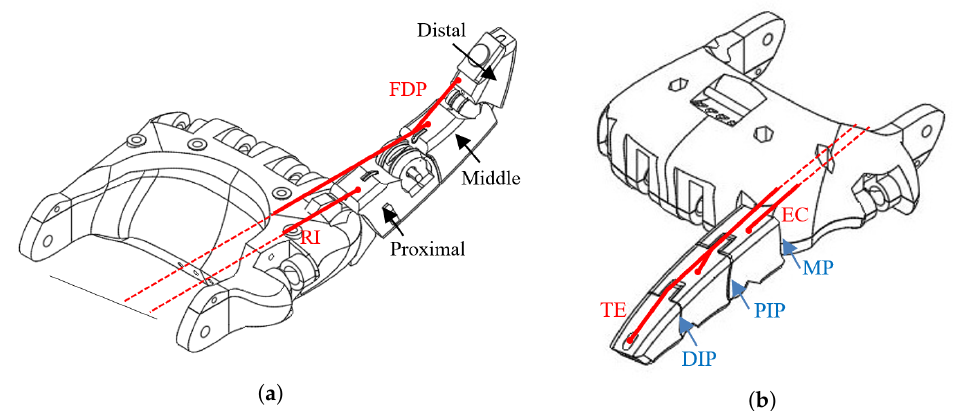
Figure 1. Mechanical structure of the artificial finger that is driven by the SMA wires: ( a ) FDP and RI for flexion and ( b ) TE and EC for